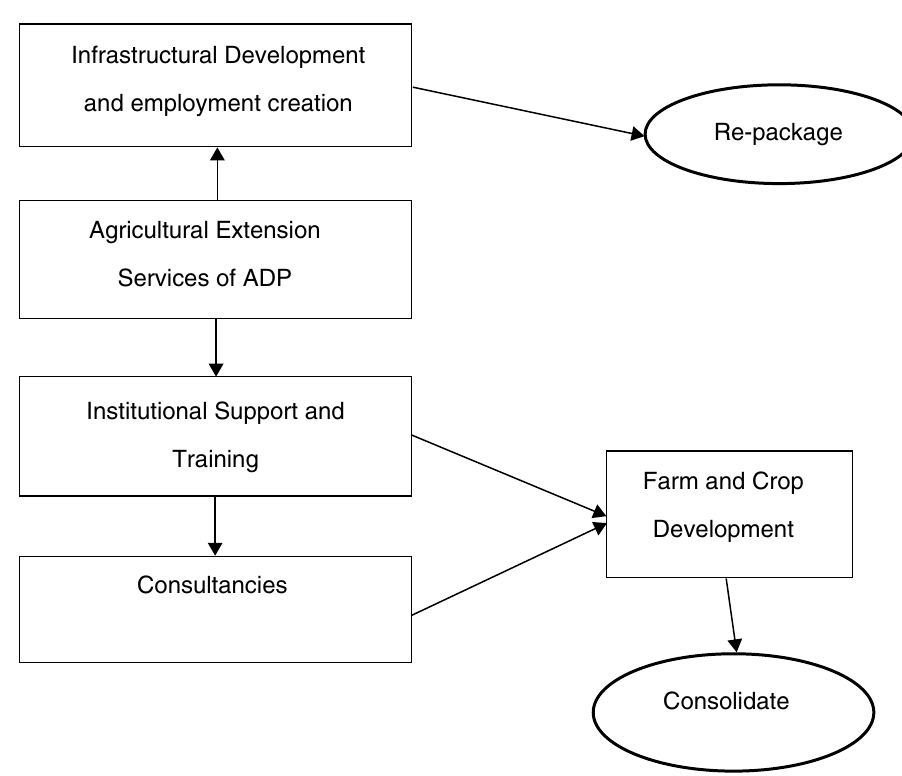
Figure 2. Suggested model of Agricultural Development Programme (ADP) performance in Edo State,